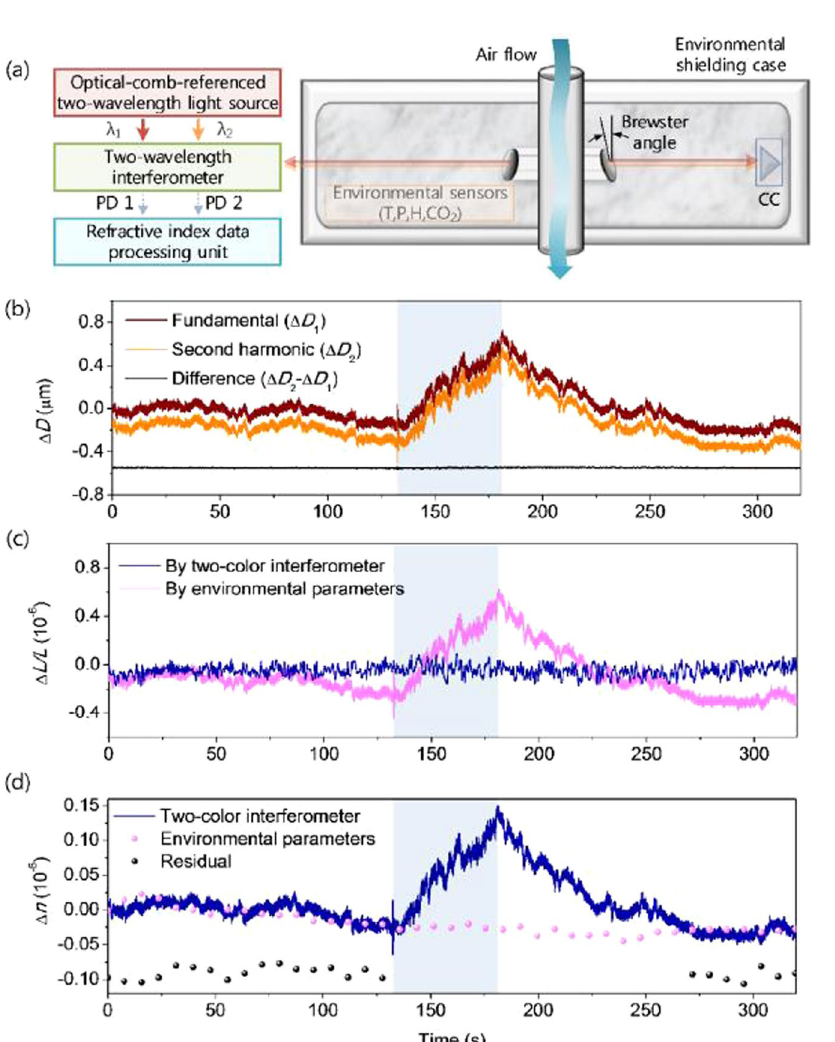
Figure 9. Two-color measurement in dynamic environment 14